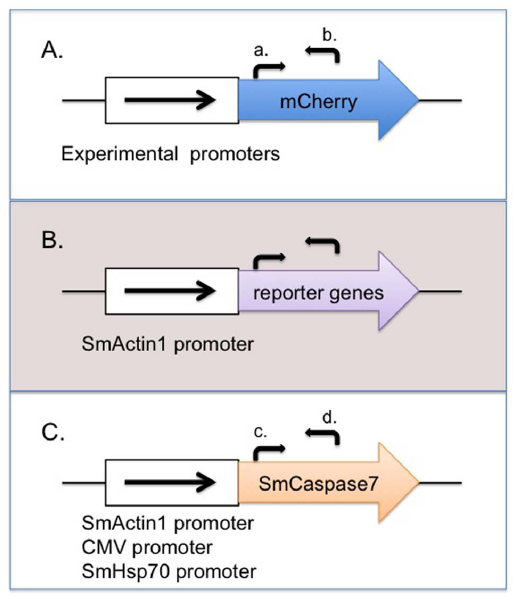
Figure 1. Schematic of expression plasmids used for transfec- tion experiments. (A) Six promoters, two viral (CMV and SV40) and four endogenous (SmHsp70, SmActin1, Sm23, and SmCalcineurinA), were used to regulate expression of an mCherry reporter gene. These promoters were separately subcloned into vector pCI-Neo to make plasmids pEJ1175, pEJ1500, pEJ1501, pEJ1502, pEJ1503, pEJ1504, respectively. Forward arrow (a) and reverse arrow (b) represent forward oligonucleotide (a) and reverse oligonucleotide (b), used to quantify mCherry transcript levels by qRT-PCR. (B) The schistosome Actin1, CyclinB, Caspase3, and Caspase7 genes are separately regulated by the plasmid-based SmActin1 promoter. Forward and reverse arrows represent DNA oligonucleotides used for qRT-PCR analysis of each transcript (Table S2). (C) Transcript levels of the schistosome Caspase 7 gene were regulated by plasmid-based SmActin1, SmHsp70, or CMV promoters. DNA oligos (c) and (d) were used for qRT-PCR analysis to measure SmCaspase7 transcript levels directed by each